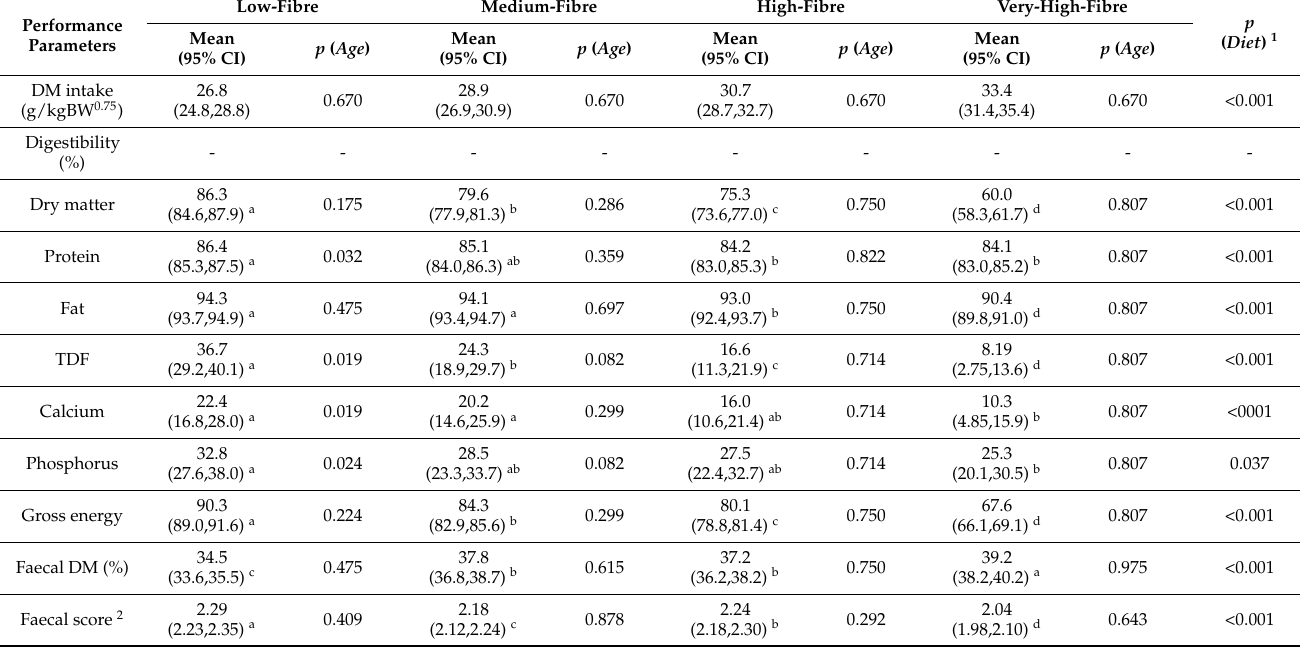
Table 5. Mean and 95% confidence intervals (CI) for dry matter (DM) intake, apparent digestibility of DM and nutrients, faecal DM and consistency score in dogs. p -Values indicate effects of diet within dogs of 2–14 years and of age within each